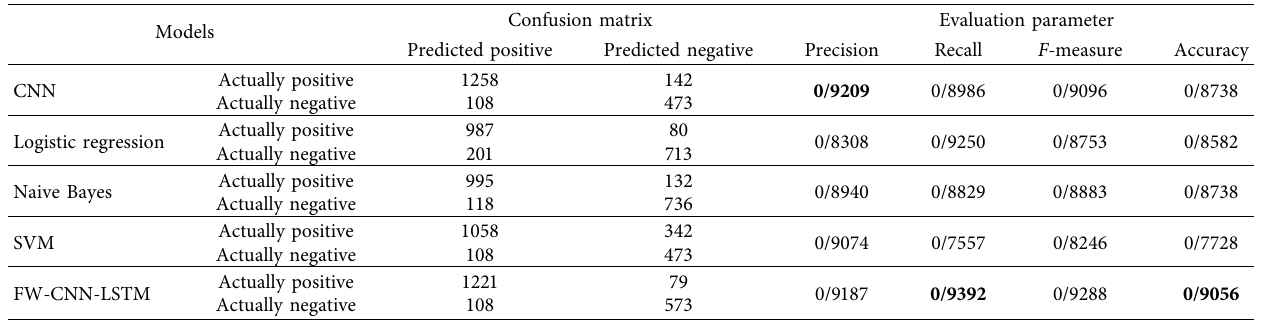
Table 8: Evaluation parameters for the Instagram dataset.